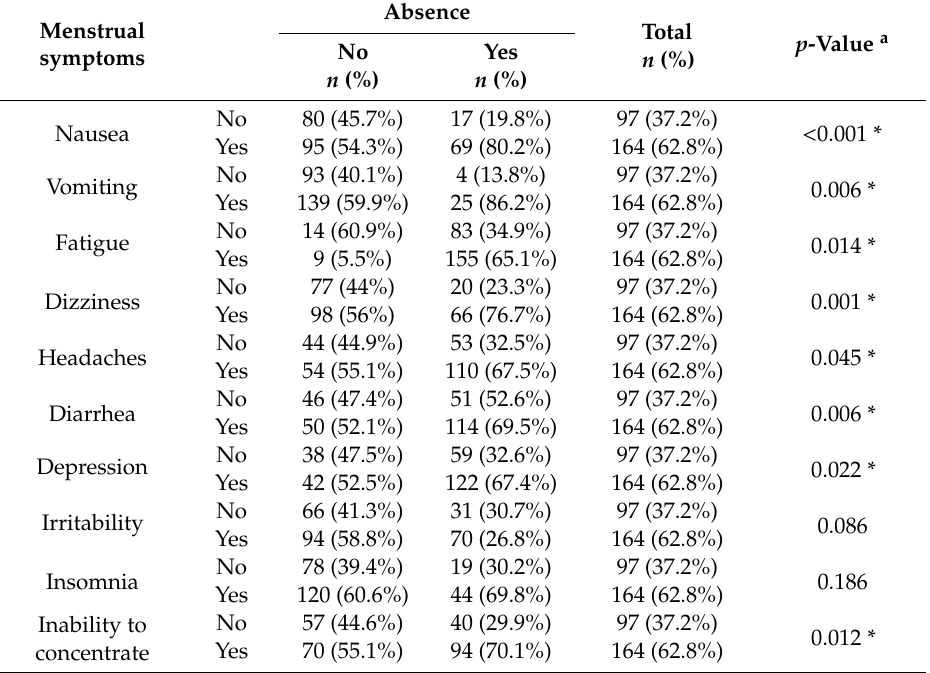
Table 5. Menstrual symptoms and absenteeism.